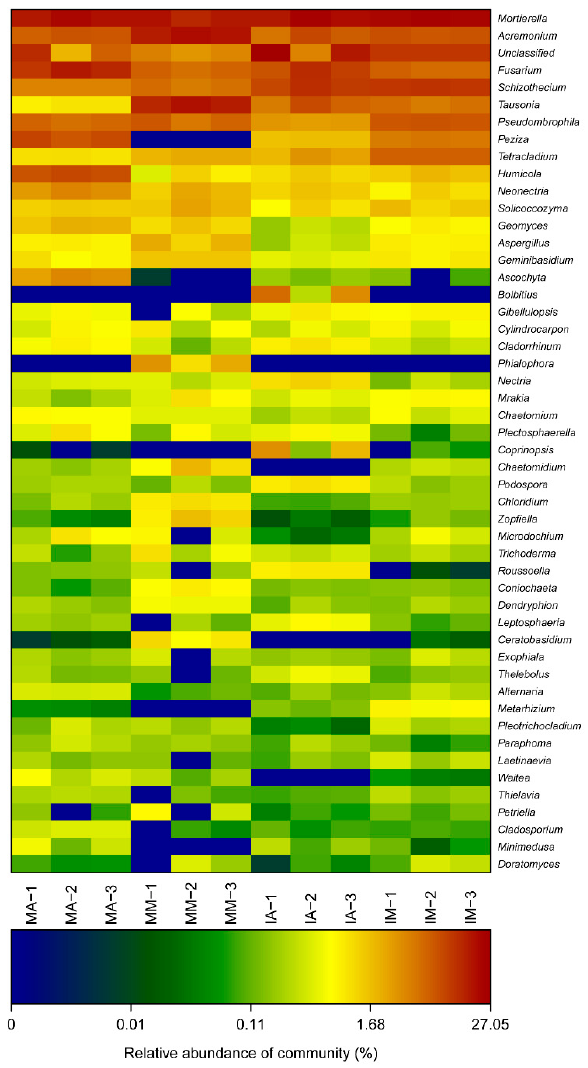
Figure 5. Hierarchical heatmap analysis of 100 predominant fungal communities in different treatments. The OTUs were ordered by genus. Sample communities were clustered based on the complete linkage method. The color intensity of scale indicates the relative abundance of each OTU read. Relative abundance was defined as the number of sequences affiliated with the OTU divided by the total number of sequences per sample. Notes: MM, IM, MA, IA represent monoculture mulberry, intercropped mulberry, monoculture alfalfa, and intercropped alfalfa, respectively. MM-1, MM-2 and MM-3 represent three repeats of MM, IM-1, IM-2, and IM-3 represent three repeats of IM, MA-1, MA-2, and MA-3 represent three repeats of MA, IA-1, IA-2, and IA-3 represent three repeats of IA.